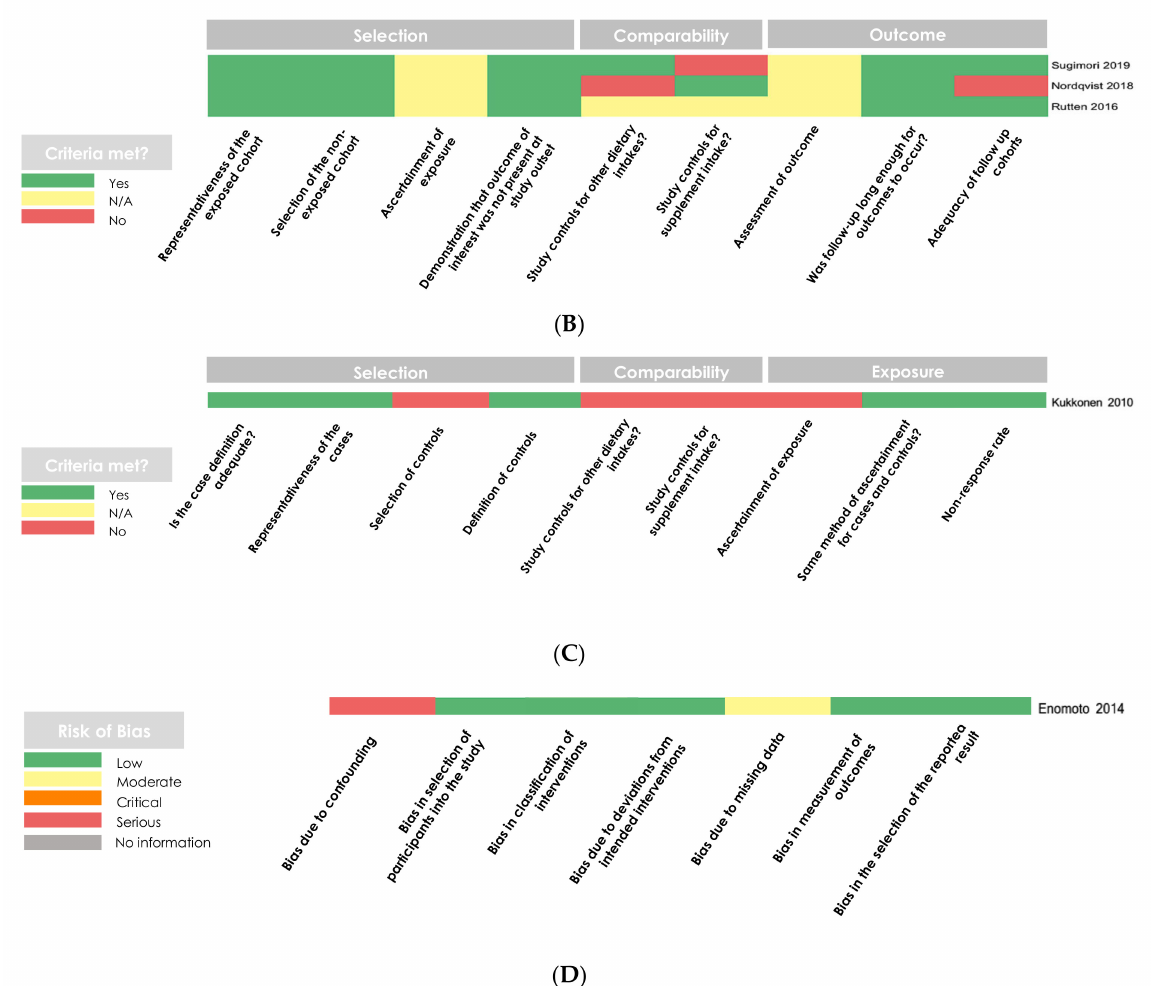
Figure 2. Heatmap of the methodological quality assessment scores for ( A ) randomized controlled trials ( n = 95), ( B ) cohort studies ( n = 3), ( C ) case-control studies ( n = 1), and ( D ) controlled clinical trials ( n = 1). For RCTs, green = low risk of bias, yellow = unclear risk of bias, red = high risk of bias. For cohort and case-control studies, green = criteria met, yellow = N/A, and red = criteria not met. For controlled clinical trials, green = low risk of bias, yellow = moderate risk of bias, orange = critical risk of bias, red = serious risk of bias, and grey = no